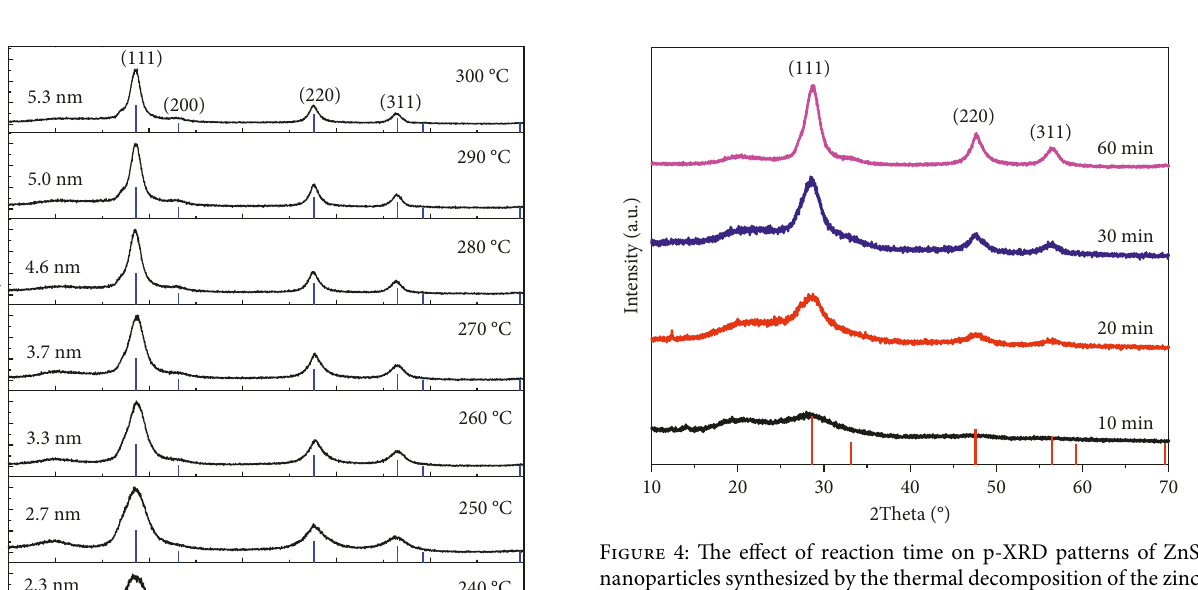
Figure 2: (a) The p-XRD pattern and (b) the TEM image of ZnS nanoparticles obtained by decomposing the zinc ricinoleate carboxylate complex in oleylamine: dodecanethiol (1 :1) solvent mixture at 300 ° C for 1 hour. The red lines are the standard pattern for sphalerite ZnS (JCPDS